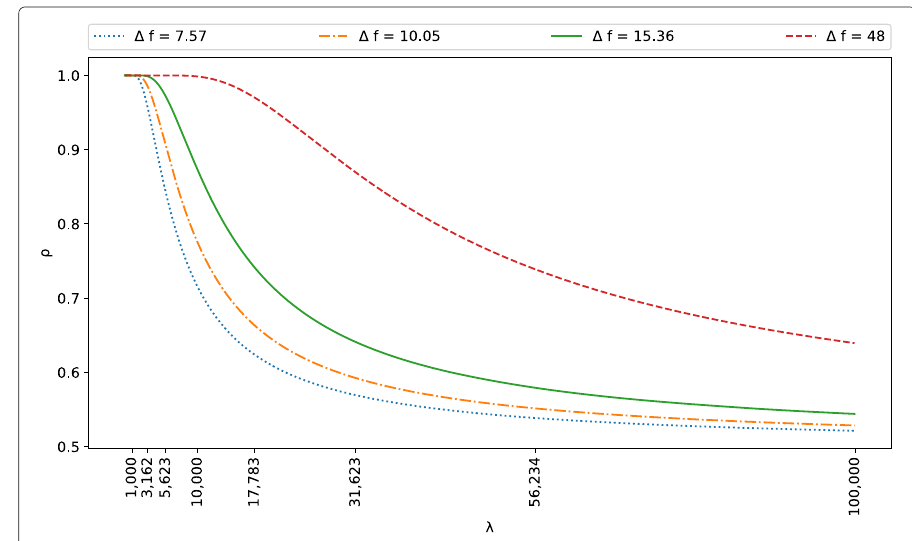
Fig. 5 Confidence ρ and forecasting MAE for various (cid:5) f under